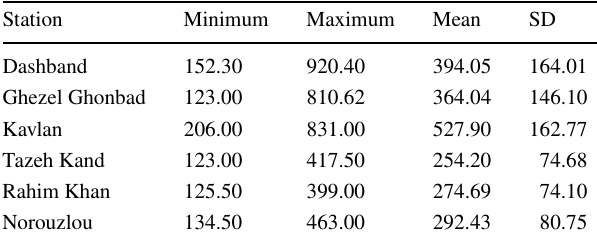
Table 1 The statistical characteristics of the investigated stations Station